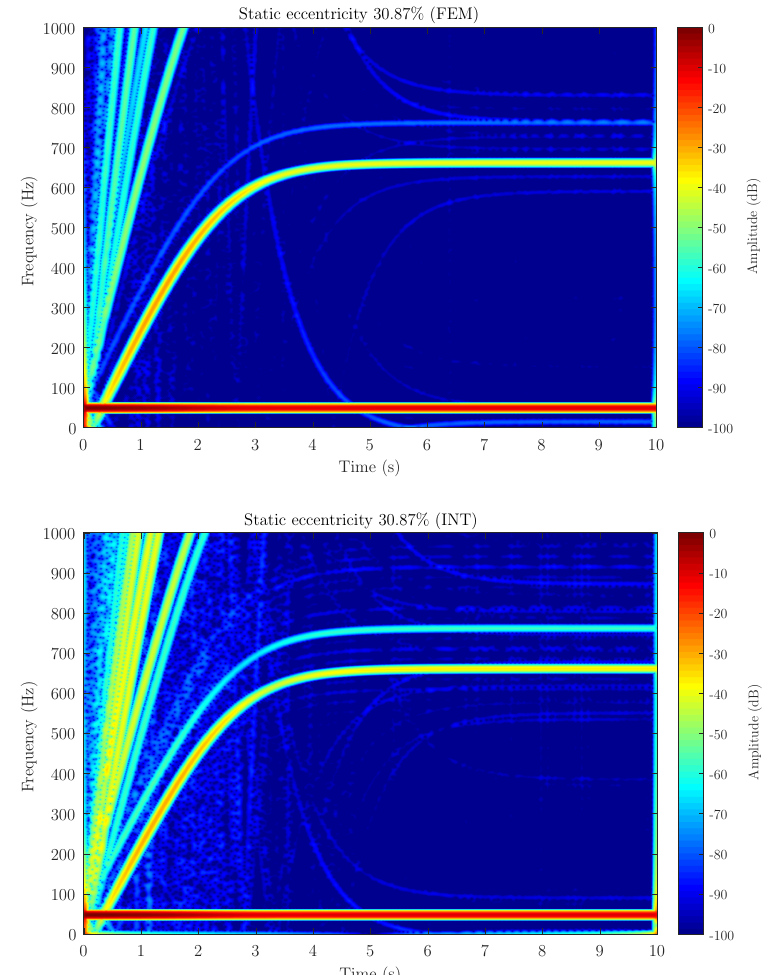
Figure 7. Stator current spectrogram for static eccentricity level 30.87% using FEM software (FEM) and the proposed method (INT) to calculate the coupling parameters of the hybrid FEM-Analytical model. The hybrid model obtains a good approximation of the amplitude for detecting the presence of the